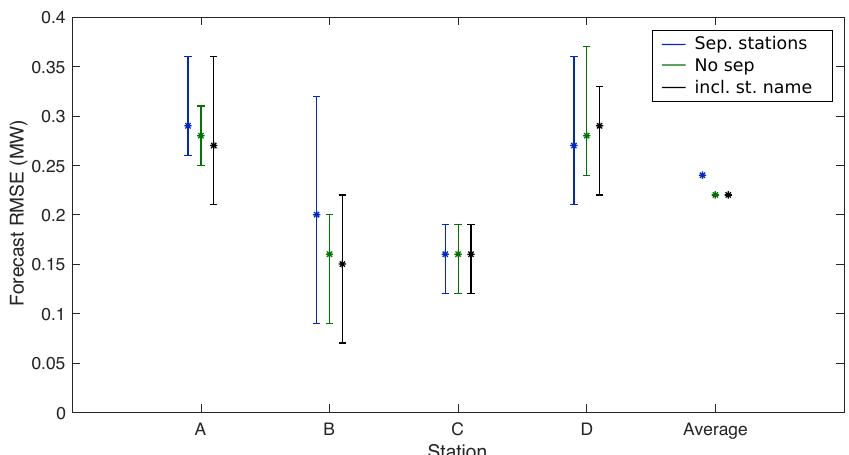
Figure 7. RMSE of the production loss forecast in MW for different sites and the three station data splitting options. The markers show the mean RMSE and the bars present the minimum-maximum of the five test/training sets. The “Average” markers is the average of the station